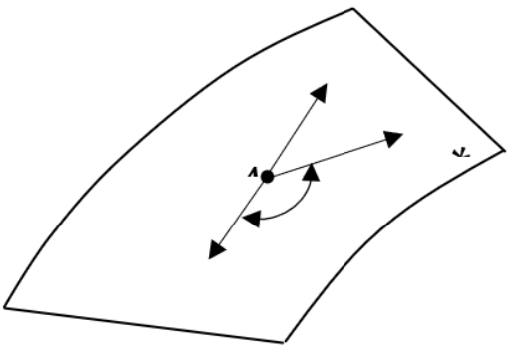
Figure 5. Orientation of actual and kinematically admissible velocities at a generic point of the friction surface.